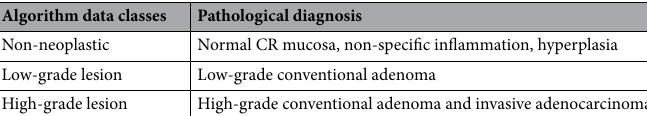
Table 3. CRC dataset class definition.